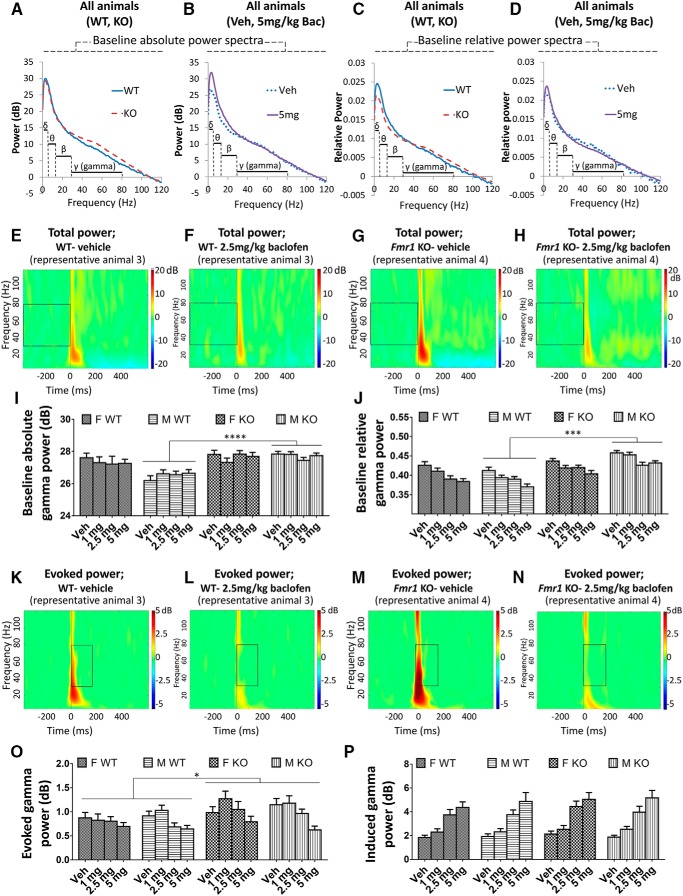
Effects of baclofen on baseline and auditory stimulus–related gamma oscillations in Fmr1 KO and WT mice (F-WT, n = 16; F-KO, n = 15; M-WT, n = 23; M-KO, n = 18). A, B, Baseline absolute power spectra in Fmr1 KO and WT mice (A), and vehicle and 5 mg/kg baclofen treatment conditions (B). C, D, Baseline relative power spectra (normalized to total 0 to 120 Hz power). E–H, Heat maps showing total power of EEG oscillations at baseline across 2 to 120 Hz frequencies from representative WT (E, F) and Fmr1 KO (G, H) mice after vehicle and 2.5 mg/kg baclofen administration. Boxes highlight baseline gamma oscillations. I, Baseline absolute gamma power. J, Baseline relative gamma power. K–N, Heat maps showing evoked power of EEG oscillations after stimulus across 2 to 120 Hz frequencies from representative WT (K, L) and Fmr1 KO (M, N) mice after vehicle and 2.5 mg/kg baclofen administration. Boxes highlight auditory-evoked gamma oscillations. O, Evoked gamma power. P, Induced gamma power. F, female, M, male, Veh, vehicle. Error bars represent SEM. *p < 0.05, ***p < 0.0005, ****p < 0.00005.